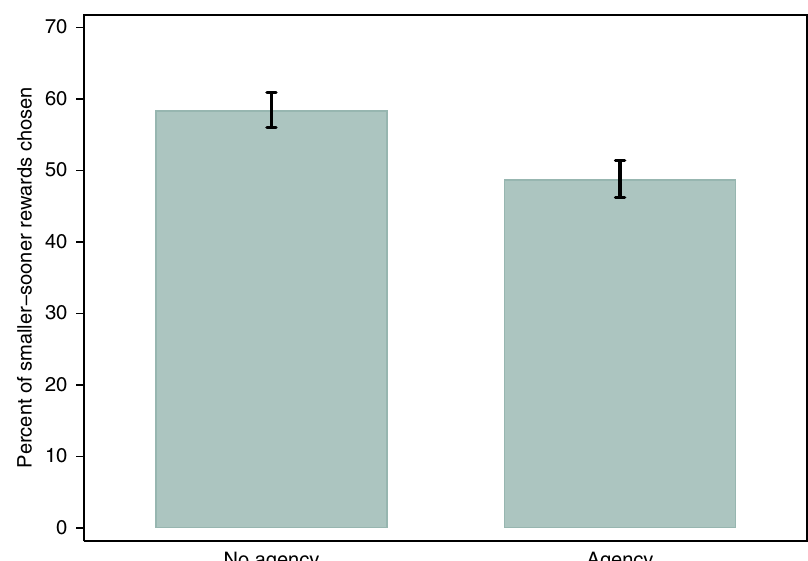
Fig. 4 Study 2 results: percent of smaller-sooner rewards chosen, by treatment group. N = 113 participants. Error bars denote mean values ± 1